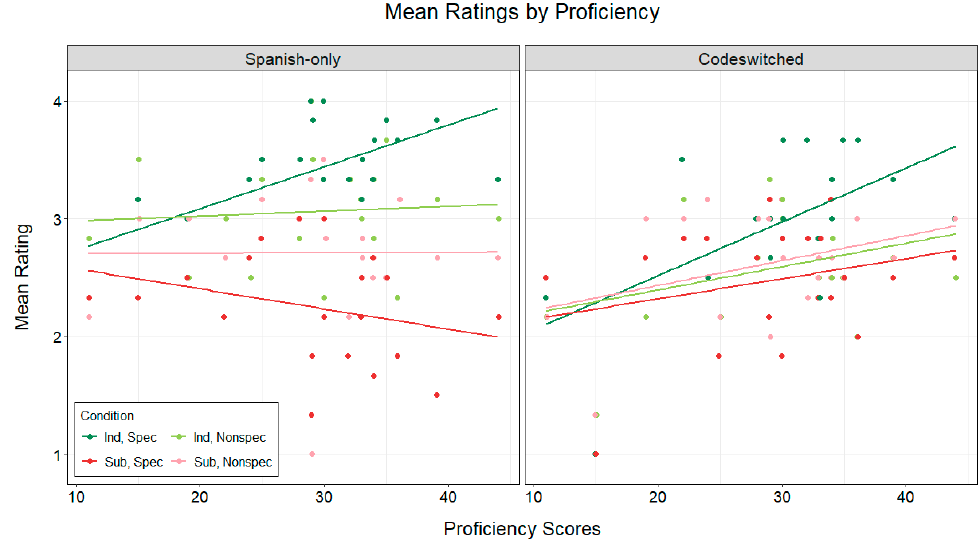
Figure 2. Proficiency and mean ratings per condition.